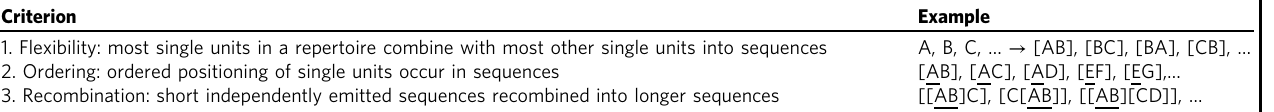
Table 1 Three structural capacities that can expand the potential to encode fl exible meaning generation.